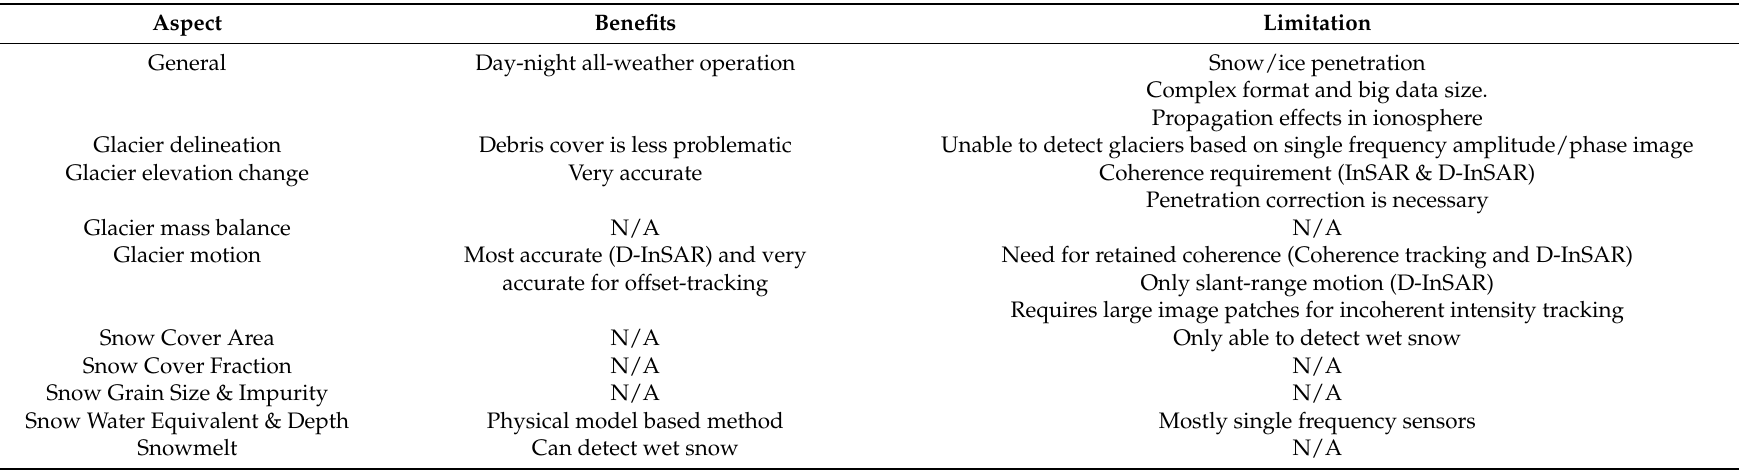
Table 4. Benefits and limitations of Synthetic Aperture Radar (SAR) imagery for cold region